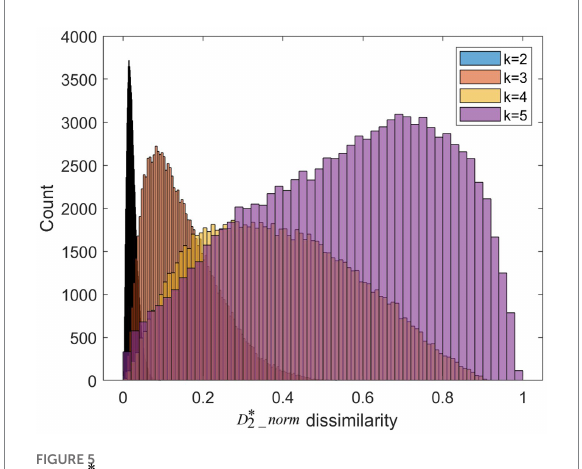
FIGURE 5 The D _ * 2 norm dissimilarities distribution for different length of k-mer. It is worth noting that the color of histogram looks like black due to the over-concentrated distribution at k = 2.